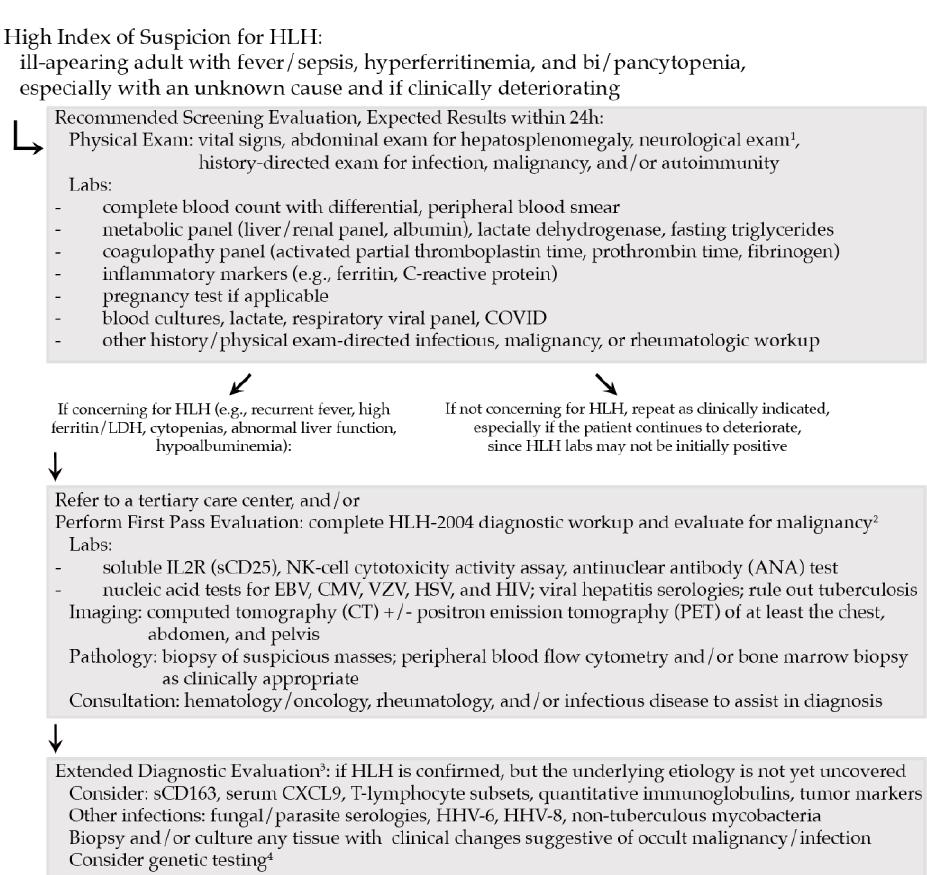
Figure 2. Schematic for Recommended Evaluation of Adult HLH. 1 Though uncommon in adults, central nervous system (CNS) manifestations of HLH are possible and should be evaluated with cerebrospinal fluid (CSF) analysis, as well as magnetic resonance imaging (MRI). 2 Given likelihood of malignancy in adults with HLH and its poor prognosis, mHLH must be evaluated promptly. If mHLH is diagnosed, complete cancer workup remains a priority. Biopsy confirmation of malignancy may not be possible in patients critically ill due to HLH; in these cases, we recommend proceeding with HLH-directed therapy, followed by pathologic confirmation when clinically stable. 3 Consider workup of other endemic causes/mimics of HLH (e.g., visceral leishmaniasis, Rickettsia ), where appropriate, based on exposures. 4 Genetic testing is recommended for suspected primary HLH (young patients or family history) or patients with HLH recurrence, as HLH variants are increasingly recognized with late HLH phenotype emergence [13]. Note: treatment-associated HLH (such as with CAR-T cells or HCT) is considered a separate diagnostic entity and does not require an extensive workup as above due to the temporal proximity of HLH clinical manifestations to the cell therapy administration [49], for which the underlying cause is more